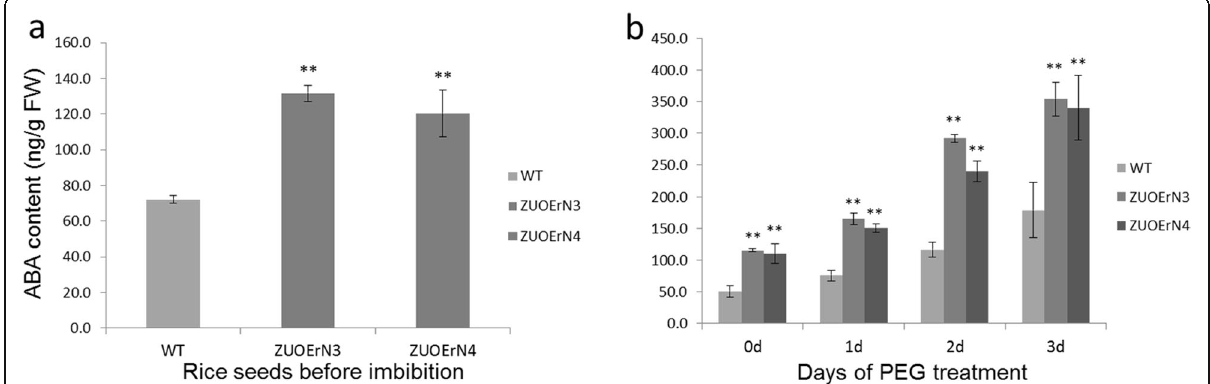
Fig. 2 ABA levels are elevated in transgenic seeds and drought-treated seedlings. ABA levels in rice seeds ( a ) and seedlings with PEG treatment ( b ). Seedlings were cultured in hydroponic solution with 10% PEG 6000 to simulate drought. Error bars show the SD of three biological replicates. ** P < 0.01 ( t